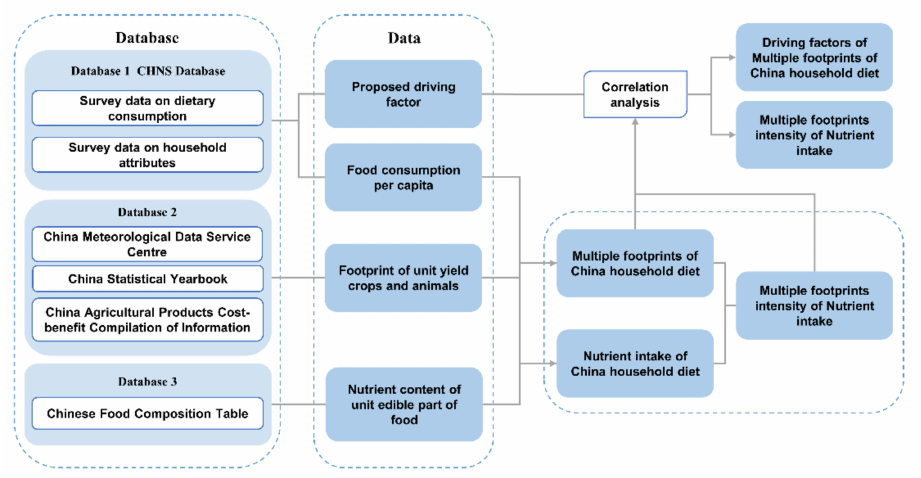
Figure 2. Research methods and processes.